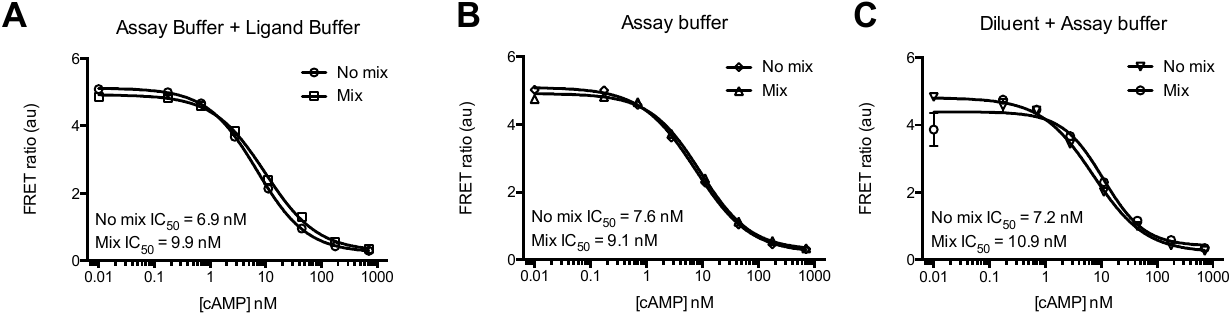
Figure 8. Standard curve of cAMP in different buffers with or without mixing of fluorophores for detection. cAMP Standard was diluted in ( A ) a 1:1 ratio of Assay buffer (HBSS + 20 mM HEPES pH 7.4) and Ligand Buffer (HBSS + 20 mM HEPES pH 7.4 + 1 µM IBMX + 10 µM forskolin; ( B ) Assay Buffer; or ( C ) Diluent (from kit) and Assay Buffer. Fluorophores were then added either as a pre-mixture or one at a time. Data are mean ± S.D. of triplicate determinations.